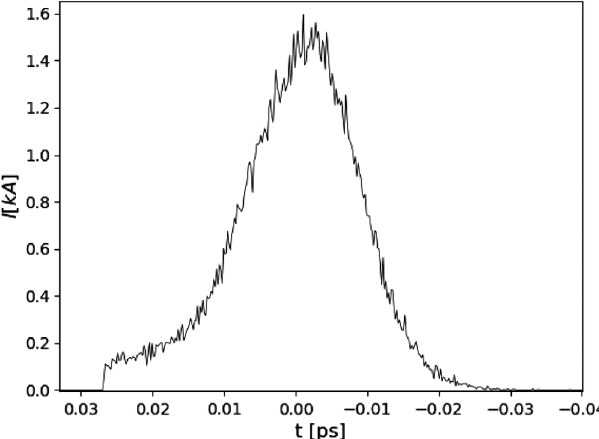
FIG. 13. Beam slice current, at maximum compression, for 31 pC bunch subset.